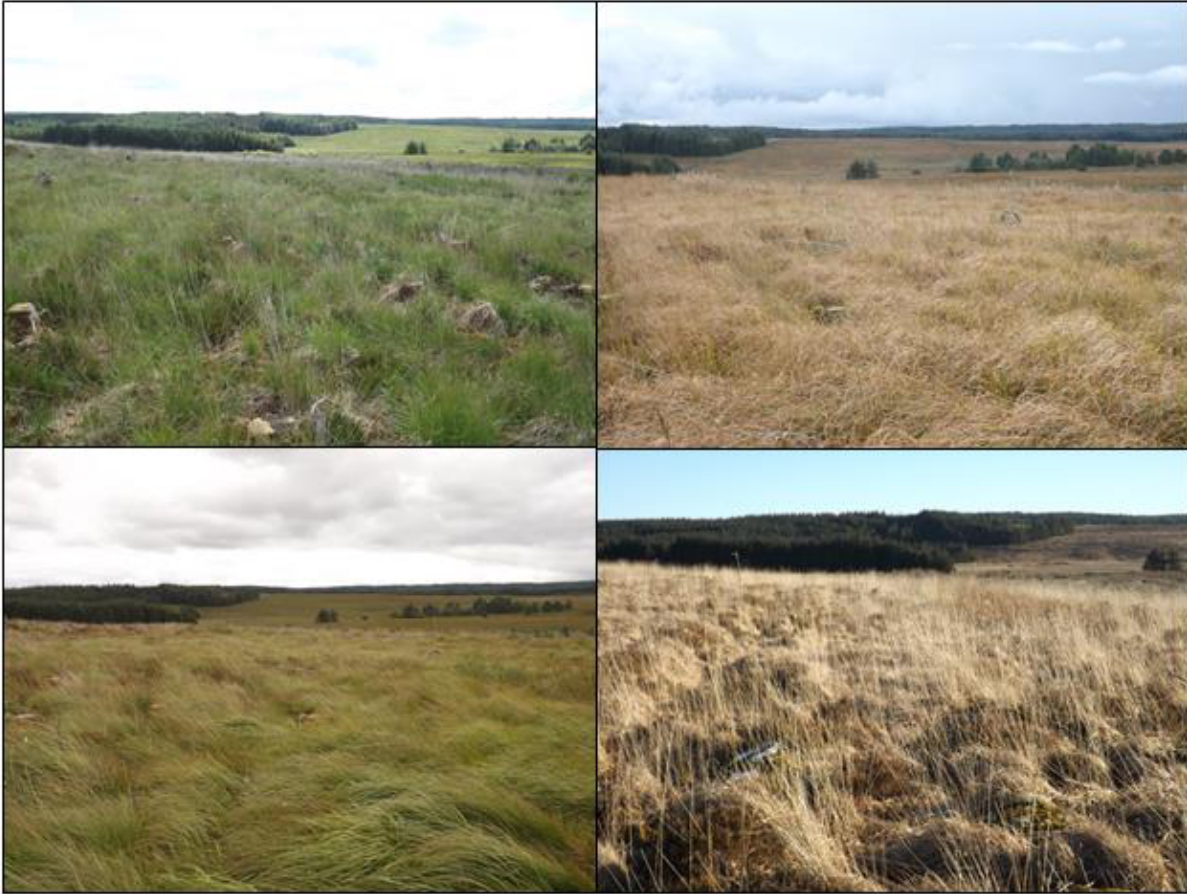
Figure 1. The Pollagoona site at different times during the two years of the study. Clockwise from top left: June 2014, October 2014, February 2015 and August